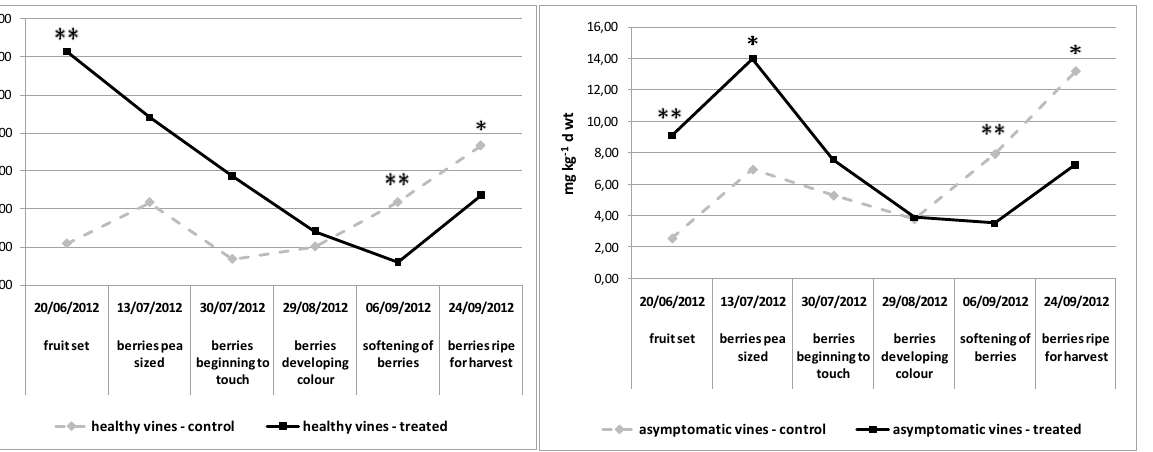
Figure 1. Mean amounts, in 2012, of trans -resveratrol Figure 1. Levels of trans -resveratrol in leaves of healthy in leaves from healthy grapevines, and from asympto- vines and of asymptomatic and symptomatic vines affected matic and symptomatic vines affected by GLSD, that by GLSD treated and untreated with foliar fertilizer in the were treated or untreated with foliar fertilizer. Each Controguerra vineyard in 2012. Each value is the mean of 6 replications of the leaf data individually obtained from 6 value is the mean of six replications of the leaf data vines for each grapevine status. The statistical analysis individually obtained from six vines for each grape- separately compared leaf data from each grapevine group vine status. The statistical analysis separately com- (healthy, asymptomatic and symptomatic; data comparison pared leaf data from each grapevine status (healthy, of treated-untreated pairs) in every phenological growth asymptomatic and symptomatic; data comparison stage of the year (following Lorenz et al ., 1995). Value of treated and untreated pairs) in each phenological followed by the symbol statistically differ (* = P = 0.05; ** = growth stage (following Lorenz et al ., 1995). Values for P = 0.01) respect to the other member of the pairs to the each pair of means followed by symbols are statisti- Student's t –test. cally different (* for P =0.05; ** for P =0.01), as indicated by Student’s t-